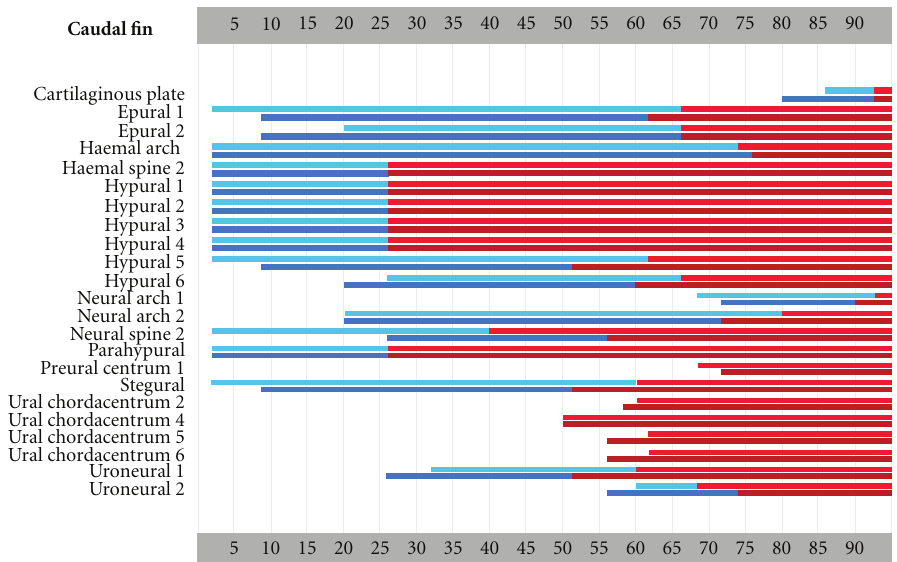
Figure 3: Sequence of chondrification and ossification for the elements of the caudal fin of Salvelinus alpinus reared in treatment S (slow, upper bars) and treatment F (fast; lower darker bars) between dph 2 and 90. Blue is for cartilage, red is for bone.